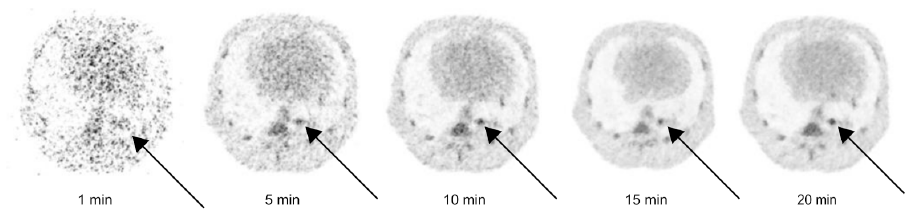
Figure 6. PET representations of multiple reconstruction time frames of the same scan visualizing the increase in signal to noise ratio (SNR) while increasing the scanning time. The black arrow points towards an abnormality. Similar window-level settings are applied to all